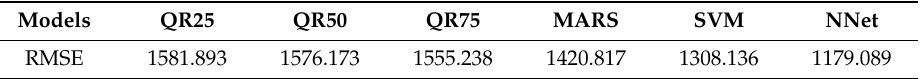
Table 6. RMSE of ROI with 2010–2015 Years data (in-sample forecast).